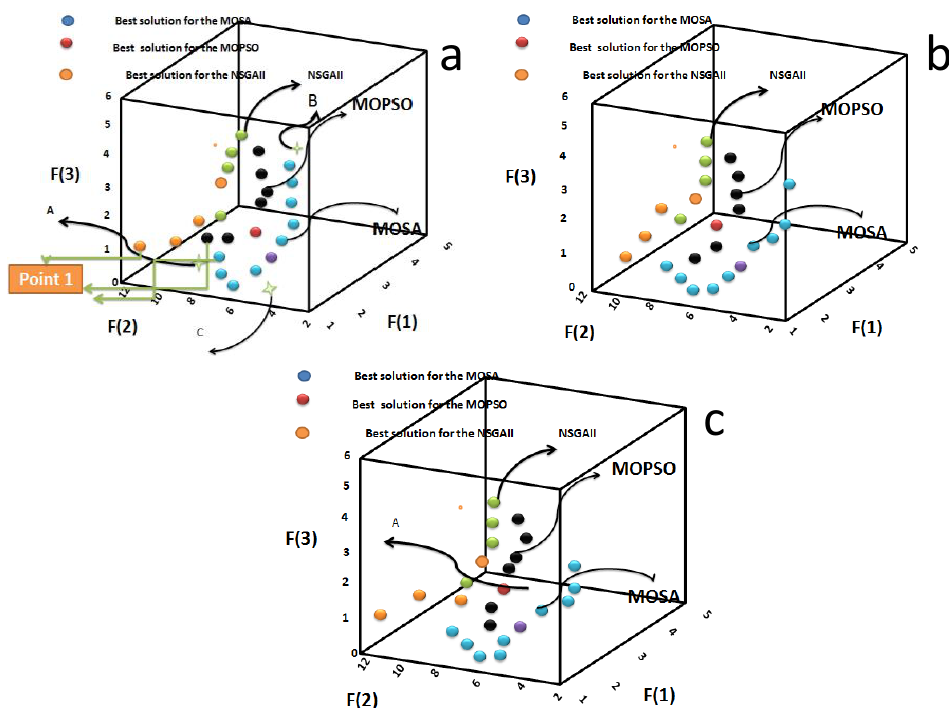
Figure 5. Pareto front for ( a ) Azarbayjen province, ( b ) Ardebil, and ( C ) Gilan.